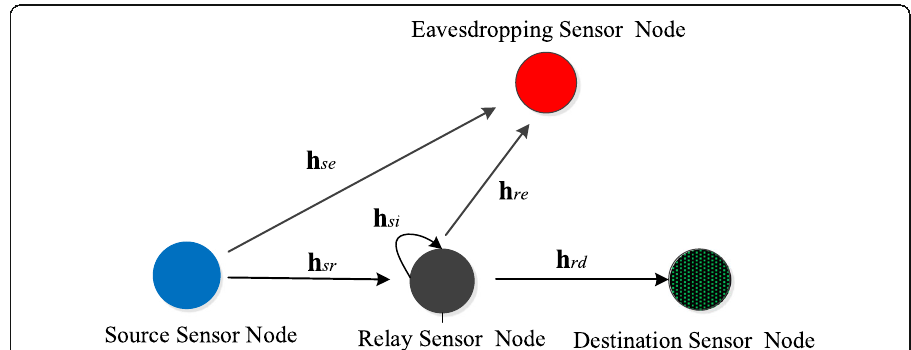
Fig. 1 System model of IoT sensors relay network. The blue node represents the source sensor node S ; the grey node represents DF full-duplex relay sensor node R ; the green node represents the destination sensor node D ; the red node represents the eavesdropping sensor node E. h sr , h se , h rd , and h re represent the links between S and R , S and E , R and D , and R and E . h si represents residual self-interference of